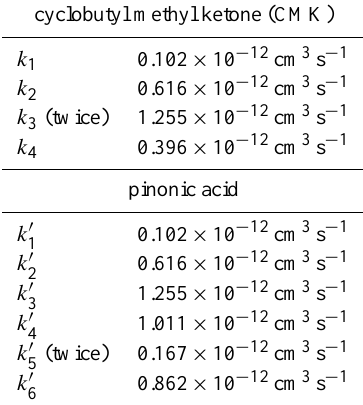
Fig. 2. Chemical mechanism following hydrogen atom abstraction from cyclobutyl methyl ketone (CMK) by a hydroxyl radical ( The numbers in brackets correspond to the molar mass of the com- pounds. See text for